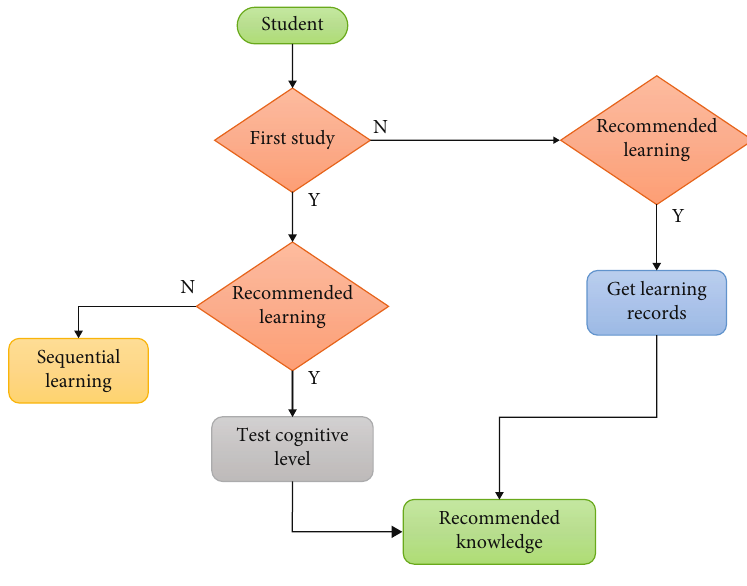
Figure 13: Personalized learning process.